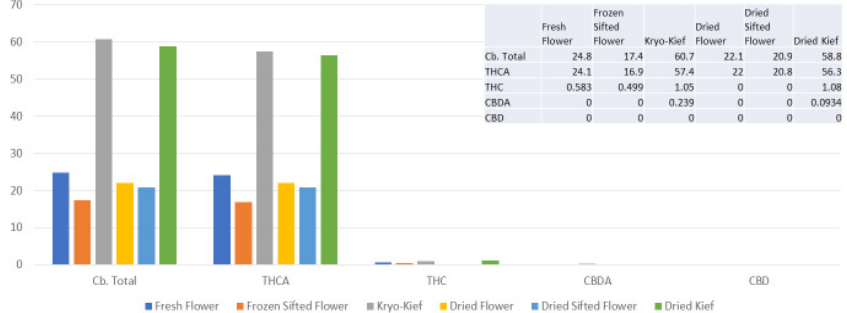
Figure 1. Doug Fir Type I chemovar cannabinoid assay results (all figures are %).